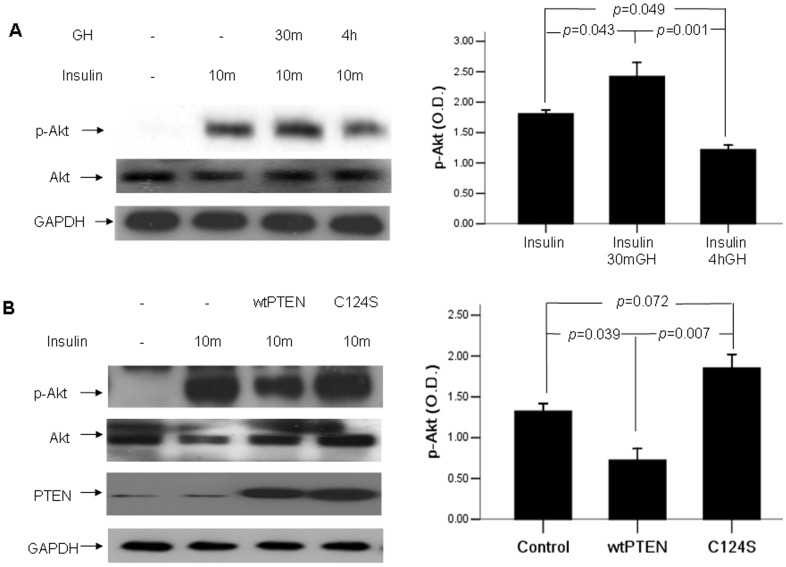
The effect of prolonged GH exposure and PTEN on Akt activity in HepG2 cells.(A) HepG2 cells were pretreated with GH or 30 min or 4 hours and harvested after insulin stimulation for 10 min. (B) Cells were transfected with wild type PTEN or PTEN mutant C124S, and harvested after insulin stimulation for 10 min. Densitometry absorbance values were averaged after they had been normalized to Akt for equal loading.